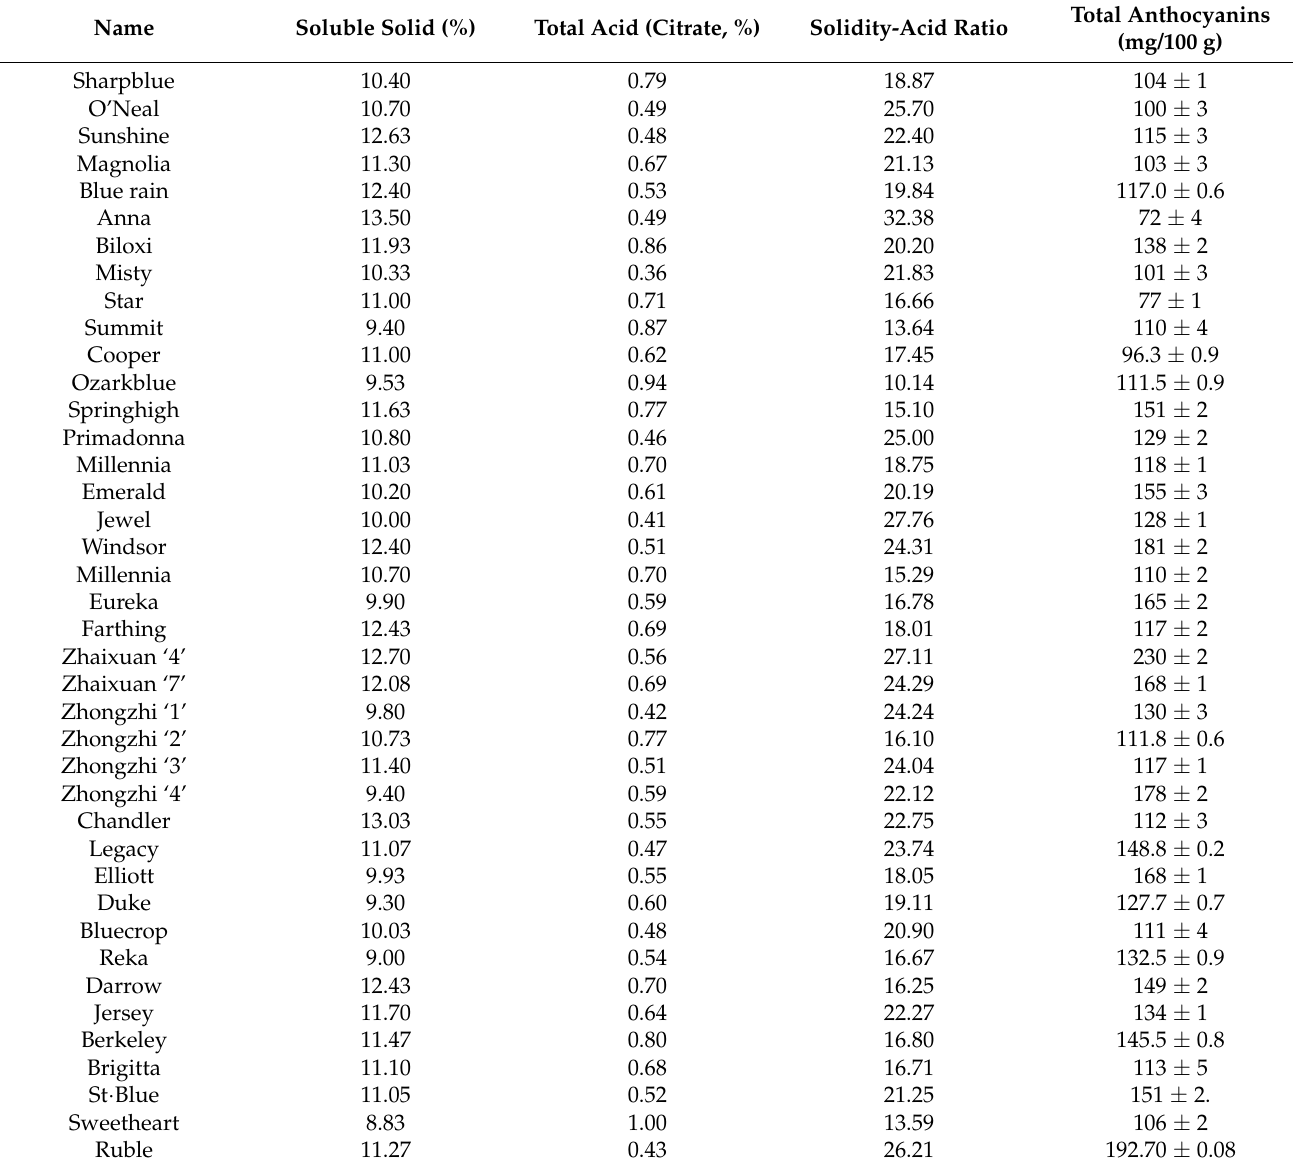
Table 1. Main phytochemicals in different varieties of fresh blueberry fruit.